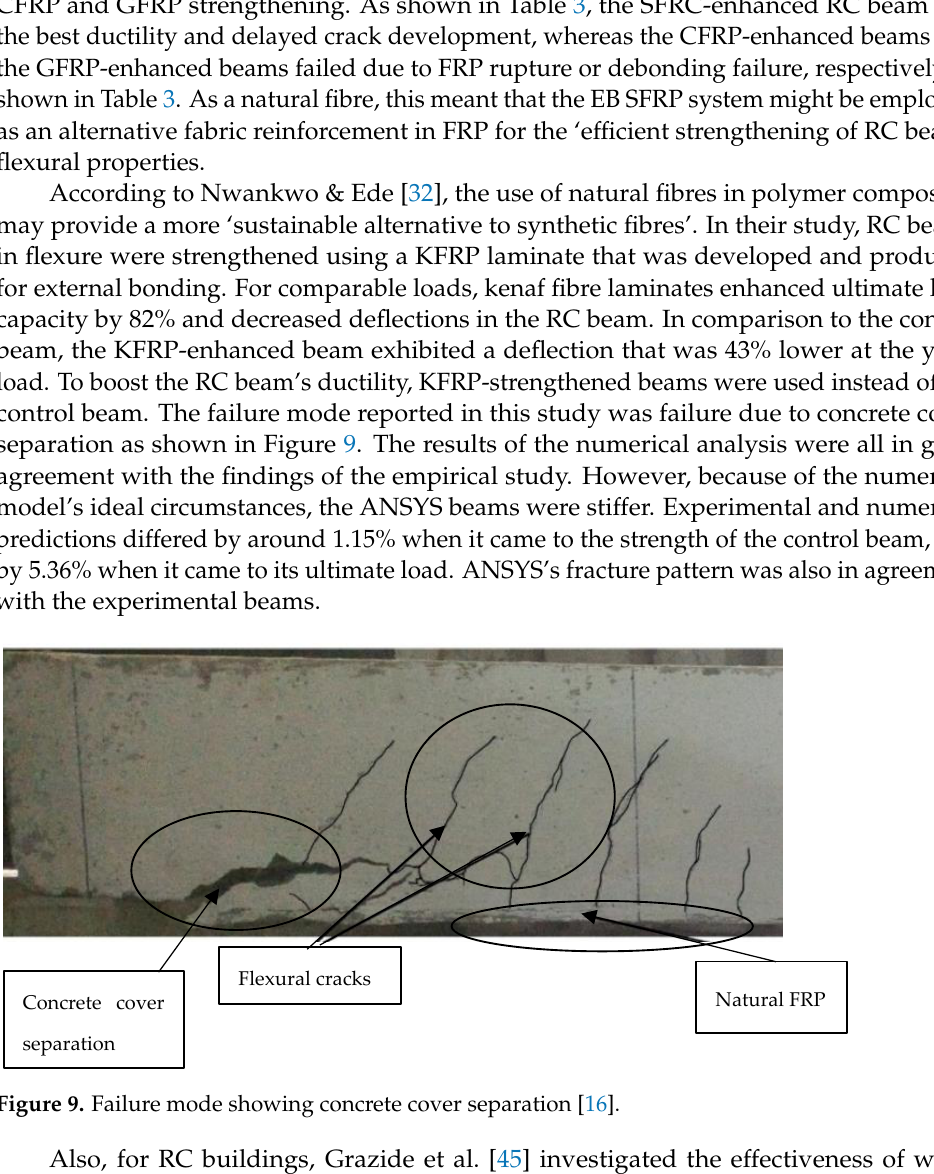
Figure 10. Stacking sequence of optimal hybrid FRP in flexure, incorporating natural fibres with overall thickness of 2.3 mm [46].